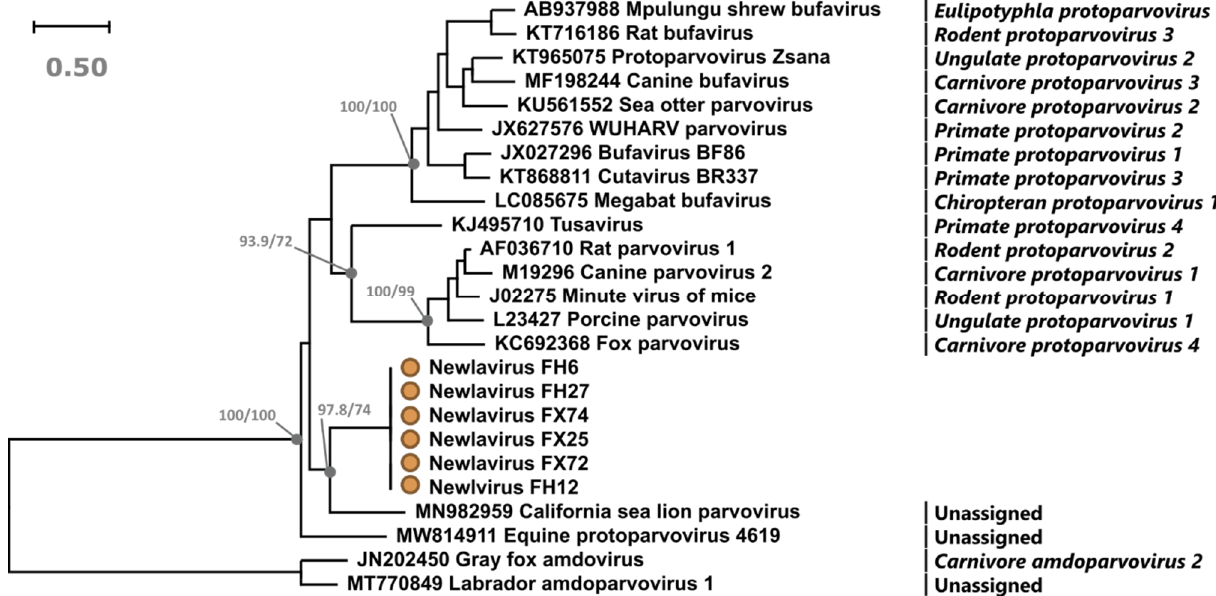
Figure 3. Phylogenetic analysis of Newlavirus and other protoparvoviruses. The phylogenetic tree based on the full NS1 protein sequences was built with the maximum-likelihood method with the rtREV + F + I + G4 model using IQ-Tree. The outcomes of the SH-aLRT and bootstrap test (1000 replicates) are shown for the main nodes. The viruses identified in this study are labelled with an orange circle and species designations, when available, are indicated on the right. Table 2. Detection rates of Newlavirus in